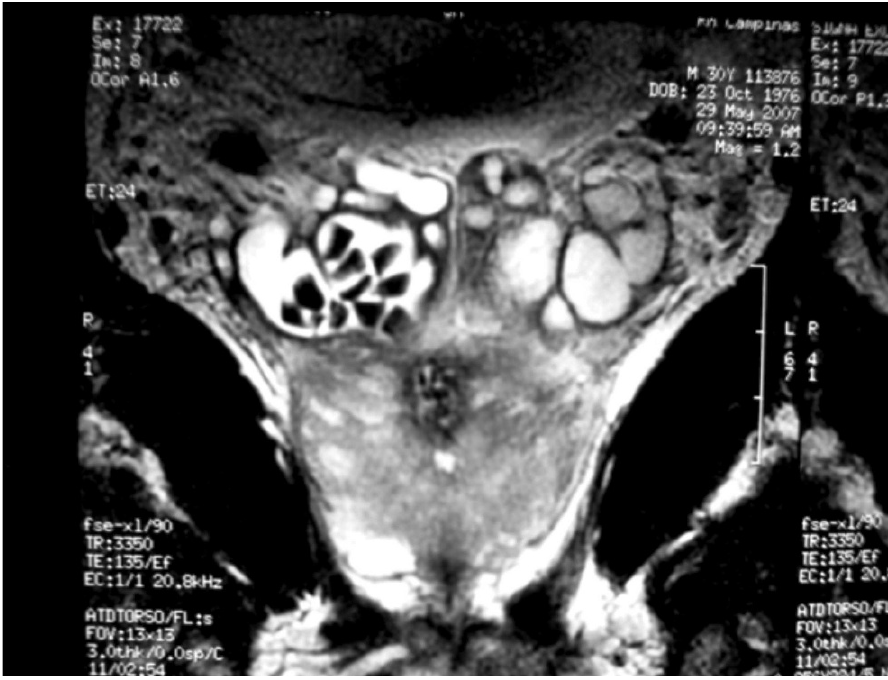
Figure 3 - Magnetic resonance imaging showing enlarged seminal vesicles with